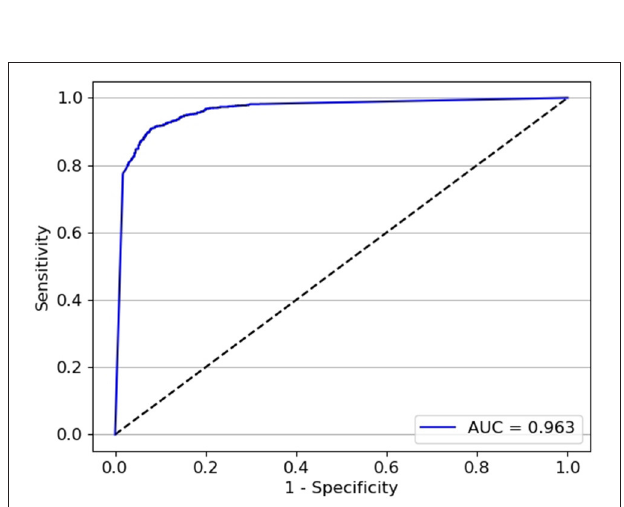
FIGURE 8 | The performance of test set 2 for the test classifier achieved an AUC of 0.963 with a sensitivity of 92.9% and specificity of